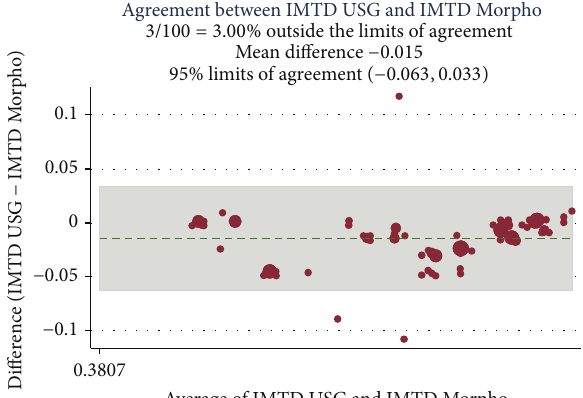
Figure 6: ICC was 0.92 with mean difference of − 0.015; limit of agreement was 95% with upper and lower limits of − 0.063 and 0.033. 3% values are above the limit of agreement, which means both of these methods are in